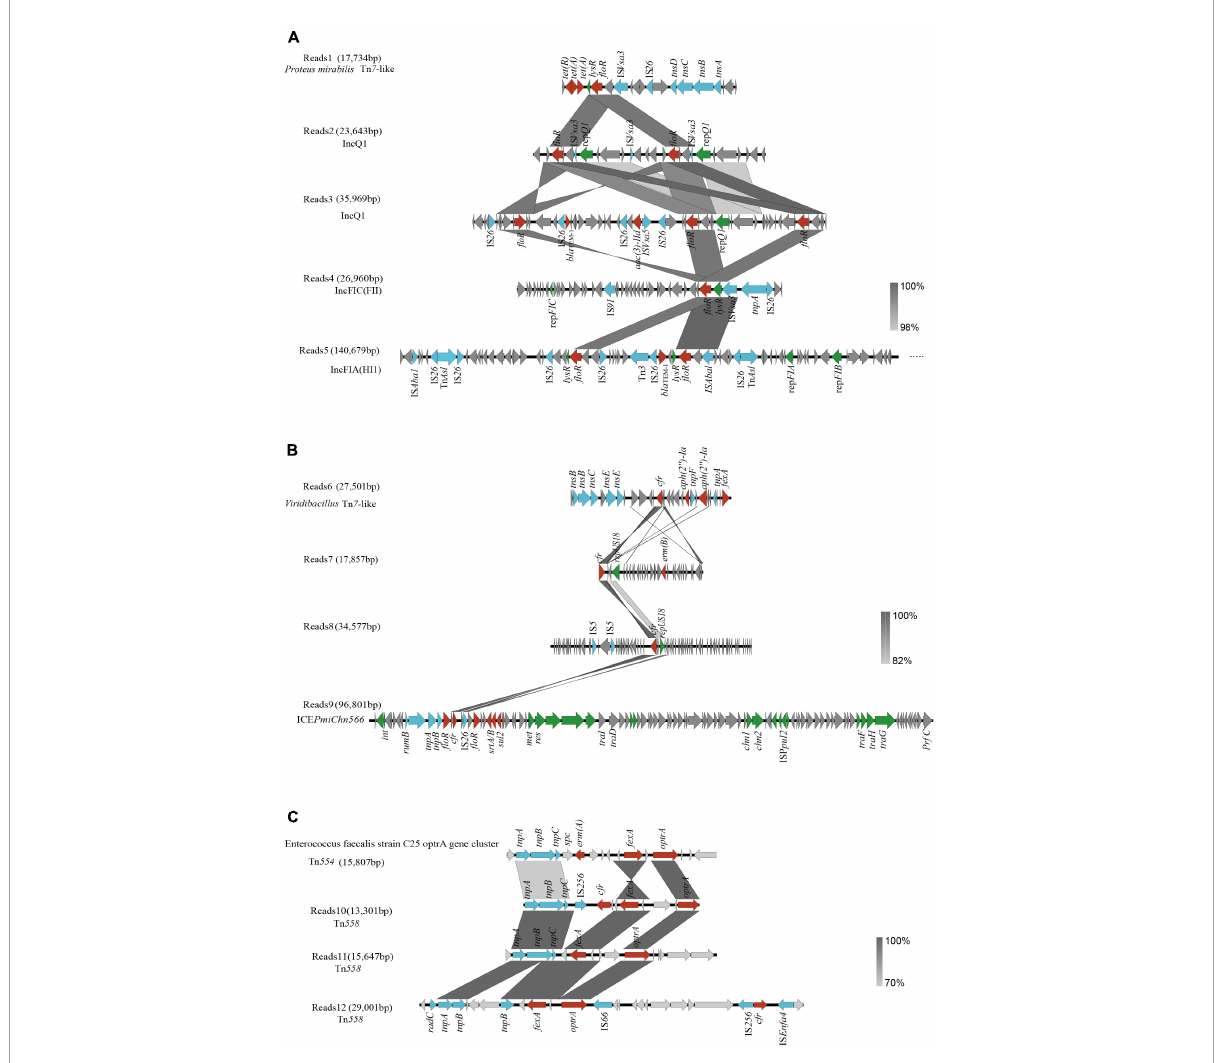
FIGURE5 Genetic context of floR , cfr , and optrA genes. (A) floR genetic context; (B) cfr genetic context; (C) optrA genetic context. Genes and open-reading frames (ORFs) are shown as arrows, and their orientations of transcription are indicated by the arrowheads. Antimicrobial resistance genes are in red, transposase elements are in blue, replication genes and other protein genes are in green, and hypothetical protein genes are in